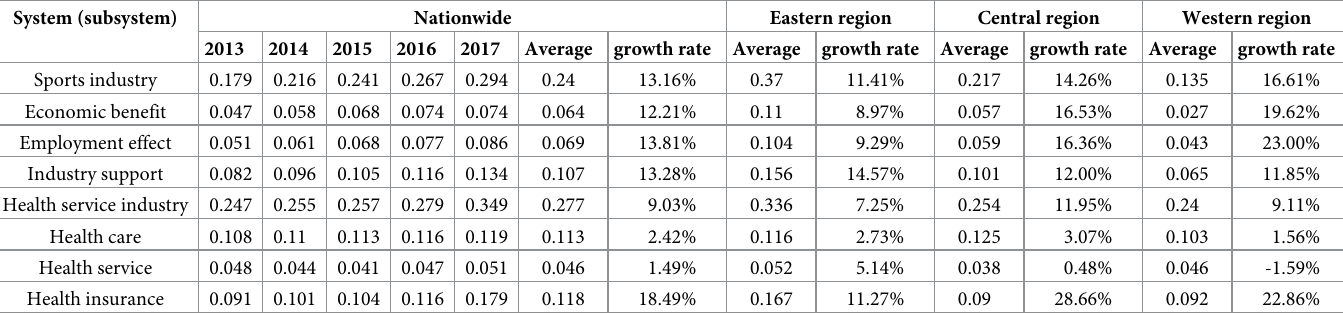
Table 3. Comprehensive index of sports industry, health service industry and various subsystems (year